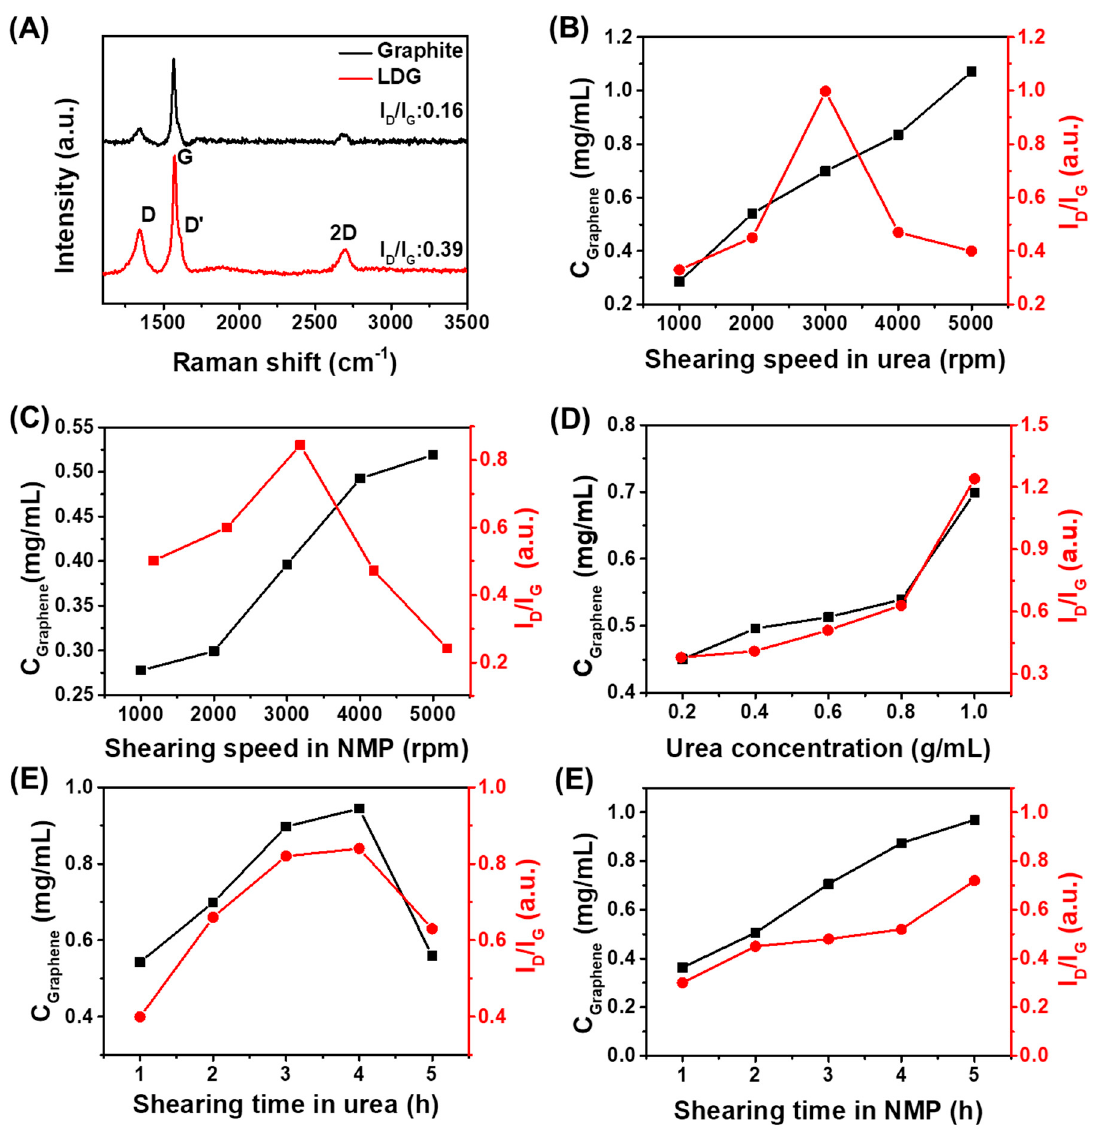
Figure 1. ( A ) Characterization of LDG by Raman spectroscopy. The influences of the processing parameters on the concentration (Left y -axis) and the I D /I G ratio in Raman spectroscopy of the LDG solutions (Right y -axis). ( B ) The shearing speed in urea, ( C ) the shearing speed in NMP, ( D ) the urea concentration, ( E ) the shearing time in urea, and ( F ) the shearing time in NMP.